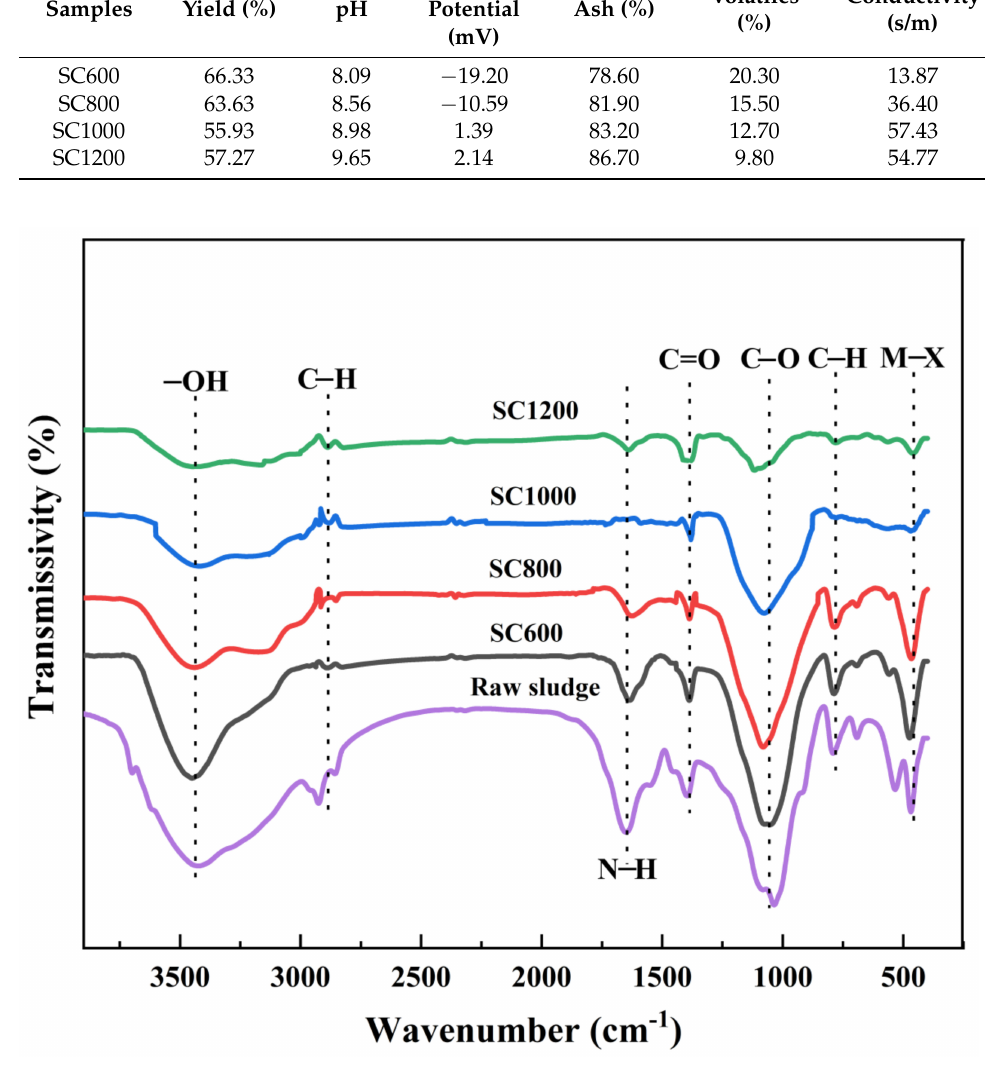
Figure 2. FTIR spectra obtained from raw sludge and SC